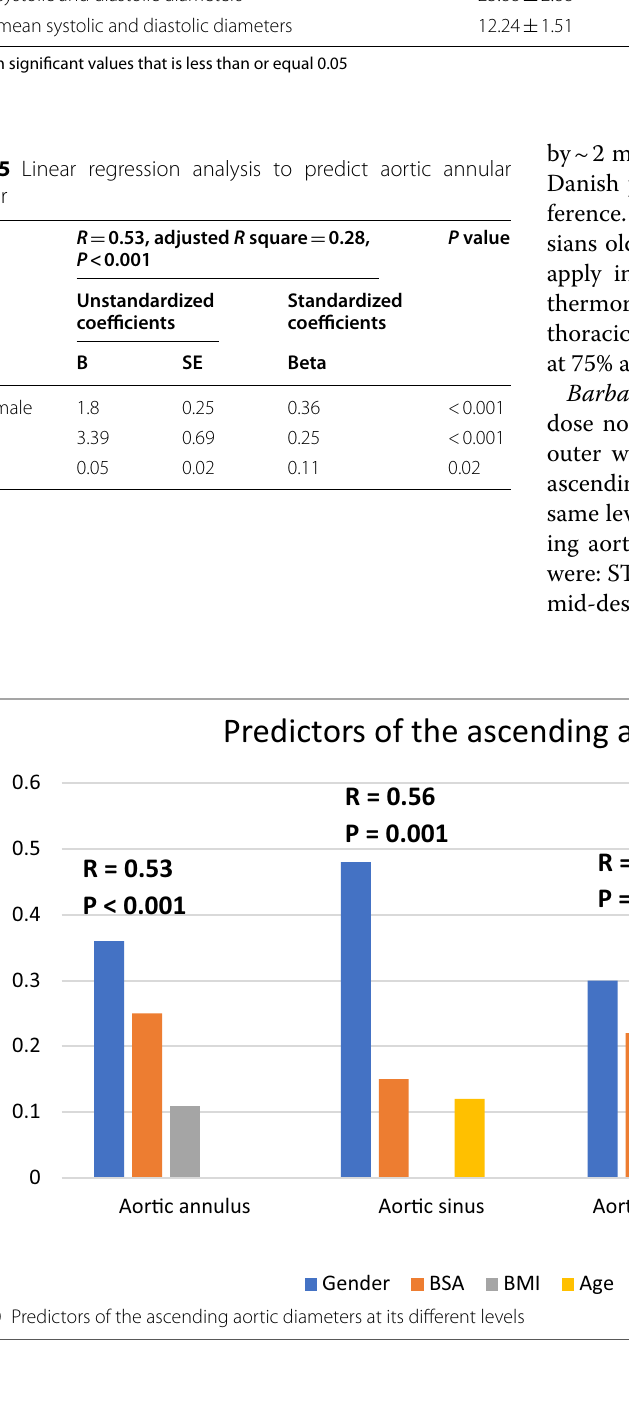
Bold mean significant values that is less than or equal 0.05